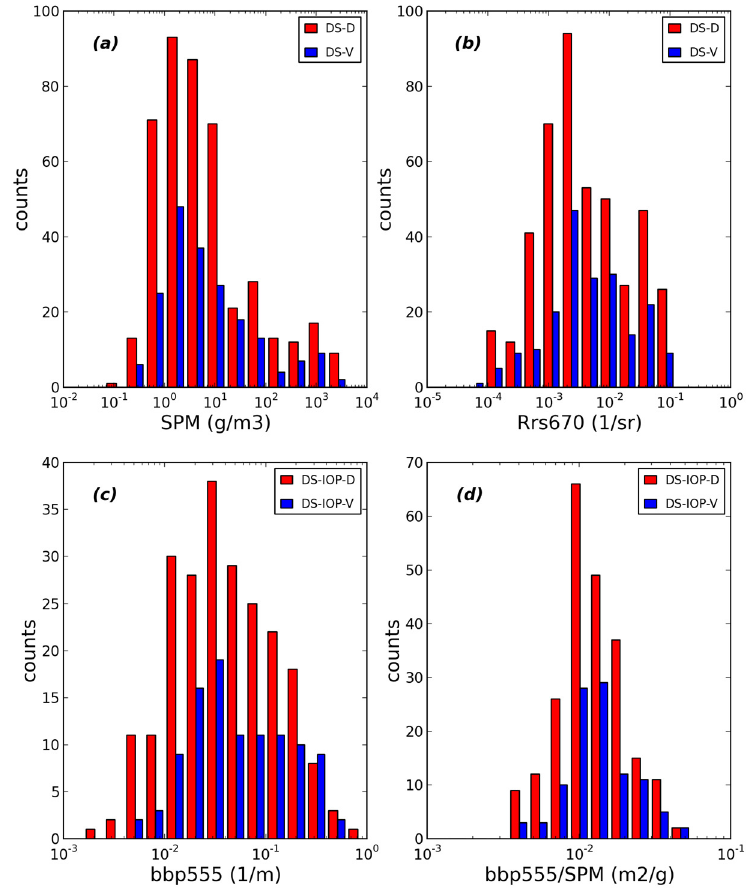
Figure 3. Frequency distribution of ( a ) SPM ; ( b ) R rs (670); ( c ) b bp (555); and ( d ) b bp (555)/ SPM in terms of logarithmically equal interval. The data used for the development and validation are represented in red and blue, respectively.